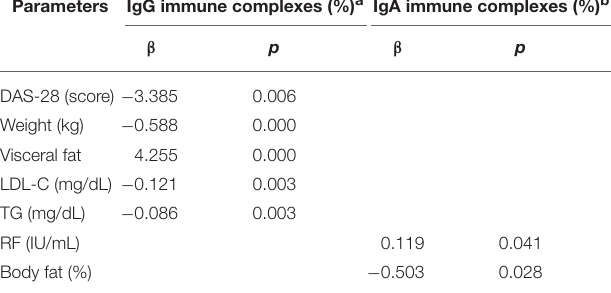
TABLE 2 | Clinical, body composition, and biochemical parameters associated with IgG and IgA anti-ghrelin immune complexes in rheumatoid arthritis patients. Parameters IgG immune complexes (%) a IgA immune complexes (%) b β p β p DAS-28 (score) − 3.385 0.006 Weight (kg) − 0.588 0.000 Visceral fat 4.255 0.000 LDL-C (mg/dL) − 0.121 0.003 TG (mg/dL) − 0.086 0.003 RF (IU/mL) 0.119 0.041 Body fat (%) − 0.503